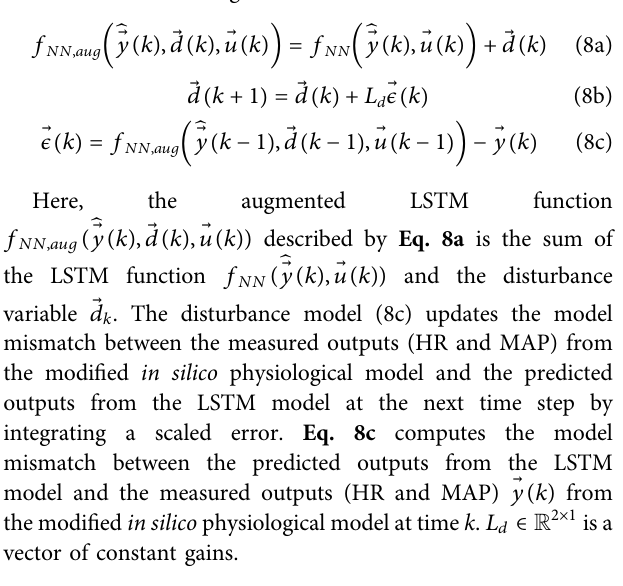
Frontiers in Physiology |